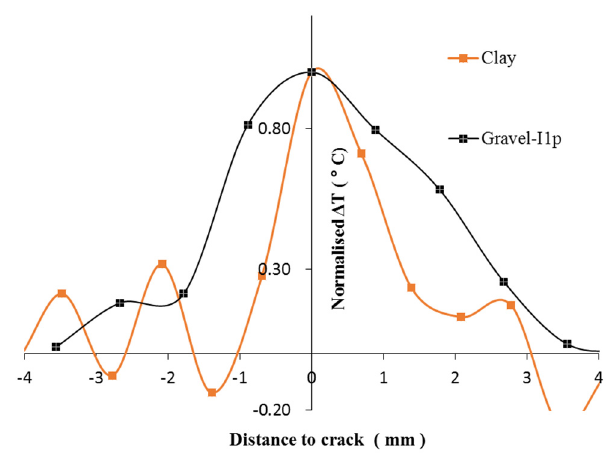
Figure 20. Comparison of Δ𝑇 normalised Δ𝑇 between clay and gravel cases.